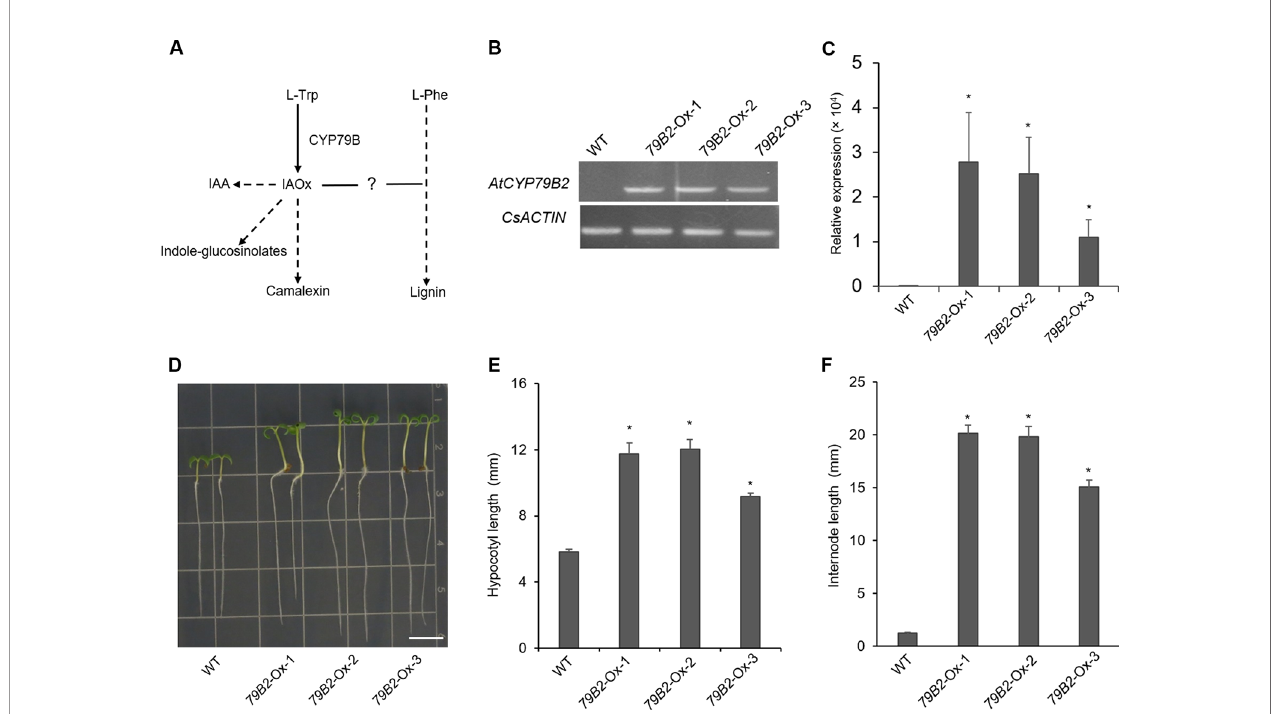
FIGURE 1 | Overexpression of AtCYP79B2 in Camelina results in characteristic morphologicalphenotypes. (A) A proposed link between IAOx metabolism and the phenylpropanoid pathway in Camelina. (B , C) Expression of AtCYP79B2 in three independent transgenic lines, 79B2- Ox-1, 79B2- Ox-2, and 79B2- Ox-3, was measured by semiquantitative RT-PCR (B) or quantitative RT-PCR (C) . Total RNA was prepared from 14-day-old Camelina leaves grown on soil and CsACTIN was used as control. In (C) , data represent mean ± standard error (SE) from four independent biological replicates. (D) Representative 7-day-old Camelina plants grown on MS plate were photographed. Bar = 1 cm. (E , F) Hypocotyl length of 7-day-old seedlings (E) and the internode length between the second leaf and the third leaf (F) were measured. 14-day-old plants grown on soil were used for the internode measurement. In (E , F) , data represent mean ± standard error (SE) (n = 16). * represents P < 0.05 (two-tailed student ’ s t-test) when compared with wild